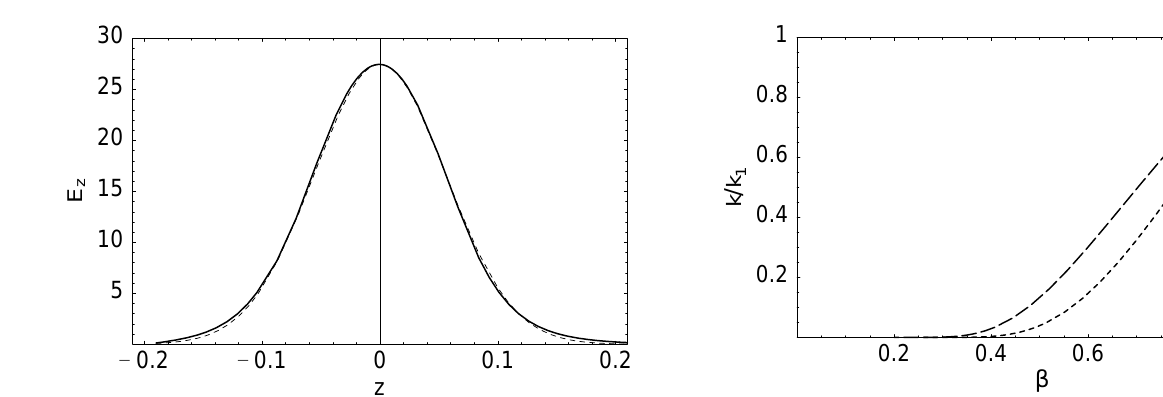
FIG. 4. The loss factor ratio versus b for the fundamental mode in 1-cell APT cavities: long-dashed line for b (cid:173) (cid:48)(cid:46)(cid:54)(cid:52) and short-dashed line for b (cid:173) (cid:48)(cid:46)(cid:56)(cid:50) . cavity, are shown for the cavity with b (cid:173) (cid:48)(cid:46)(cid:56)(cid:50) in Fig.